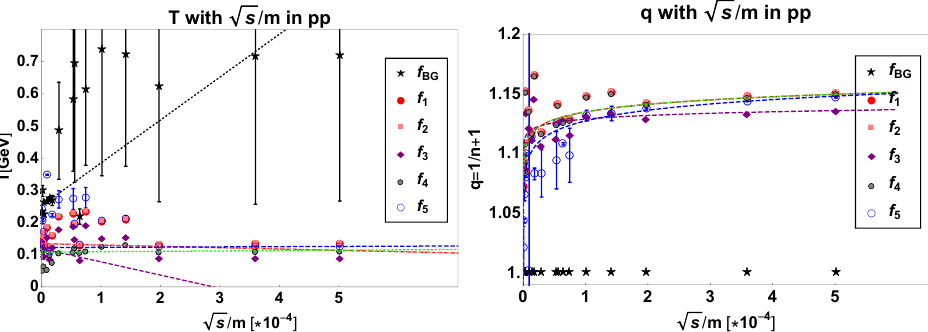
√ s and hadron mass m distributions of the fitting temperature Figure 2. Both the center-of-mass energy T and the non-extensive parameter q . In this work, we analyze the results at all given energies with the √ s = 62.4 GeV, 200 GeV, 900 GeV, 2.76 TeV, relationship cf. Equation (10). Here we list the results for 5.02 TeV, and 7 TeV. and hadron species of pions, kaons, and protons. We have extracted a factor of 10 4 √ s / m for convenience. from the values of Table 3. Fitting parameters of Equation (10) in use within Figure 2. Fitting Functions